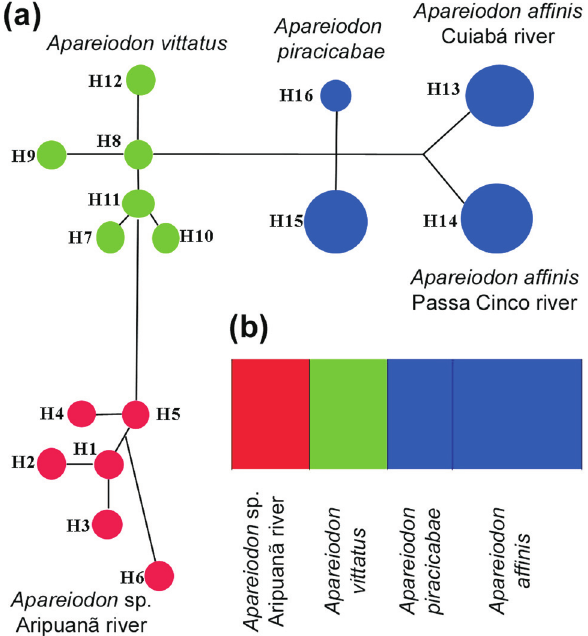
Figure 5 - Molecular data of Apareiodon sp. from the Aripuanã River. In (a), the Median Joining haplotype network of Apareiodon sp., A. vitattus , A. piracicabae , and A. affinis using COI gene data. The haplotypes are shown in different colors according to species or MOTU. In (b), BAPs data for the five analyzed species/populations of Parodontidae. The MOTU for Apareiodon sp. (Aripuanã River) is shown in red